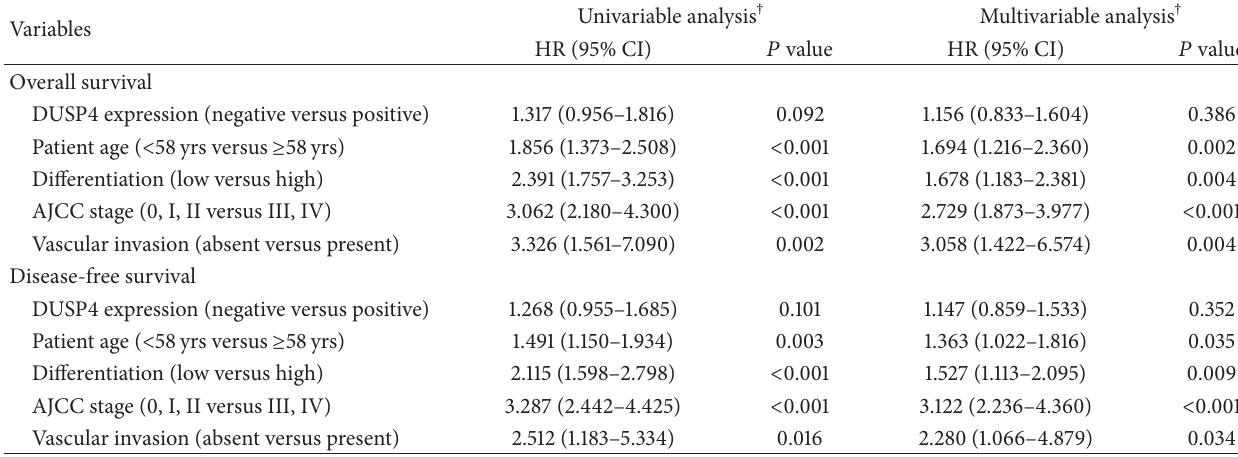
Table 3: Effect of variables on overall survival and disease-free survival in colorectal adenocarcinomas ( 𝑛 =